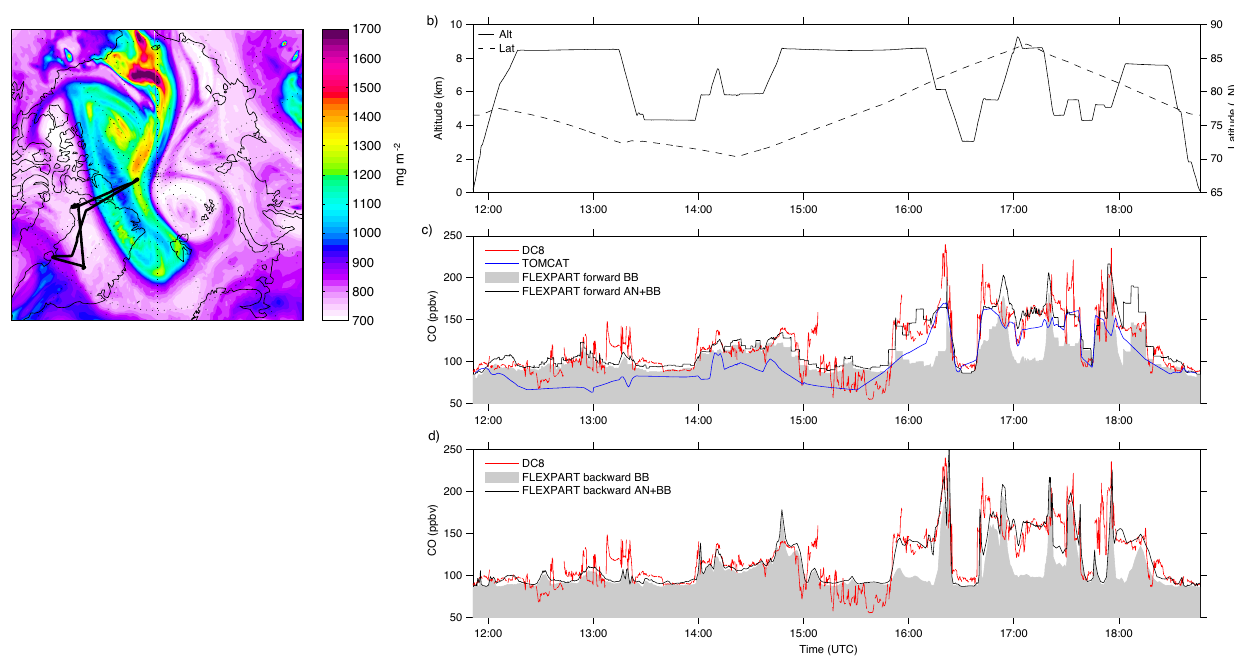
Fig. 11. Flight 22 on 9 July 2008 of the NASA DC-8. (a) Flight track (black line) overlaid on FLEXPART total column CO (mgm − 2 ) on 9 July 2008 15:00UTC. Orography has been filled with background CO concentrations to make the plume uniformly visible. (b) Flight altitude from Global Positioning System data (solid line) and latitude (dashed line). (c) CO measurements from the DC-8 (red) compared to FLEXPART biomass burning CO (gray shading), FLEXPART anthropogenic CO (black solid line) and TOMCAT model data (blue line) interpolated to the location of the aircraft in ppbv. (d) CO measurements from the DC-8 (red) compared with backward products of the FLEXPART model for biomass burning CO (gray shading) and combined anthropogenic and biomass burning CO (black line) in